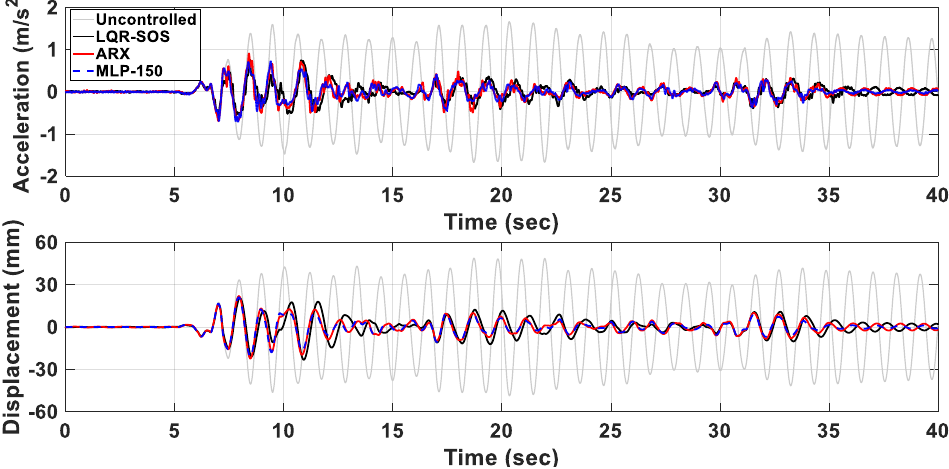
Figure 15. Time histories of the structural responses in the experimental validation.